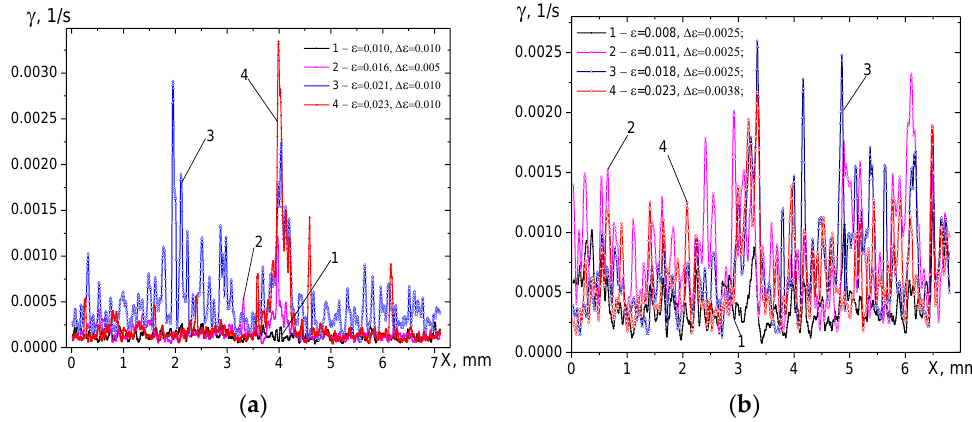
Figure 7. Spatial distribution of CPS rate  (x, y = Y m /2), measured along the midline of Specimen #1 ( a ) and Specimen #4 ( b ) at the deformation Stage I. ( a ) and Specimen #4 ( b ) at the deformation Stage